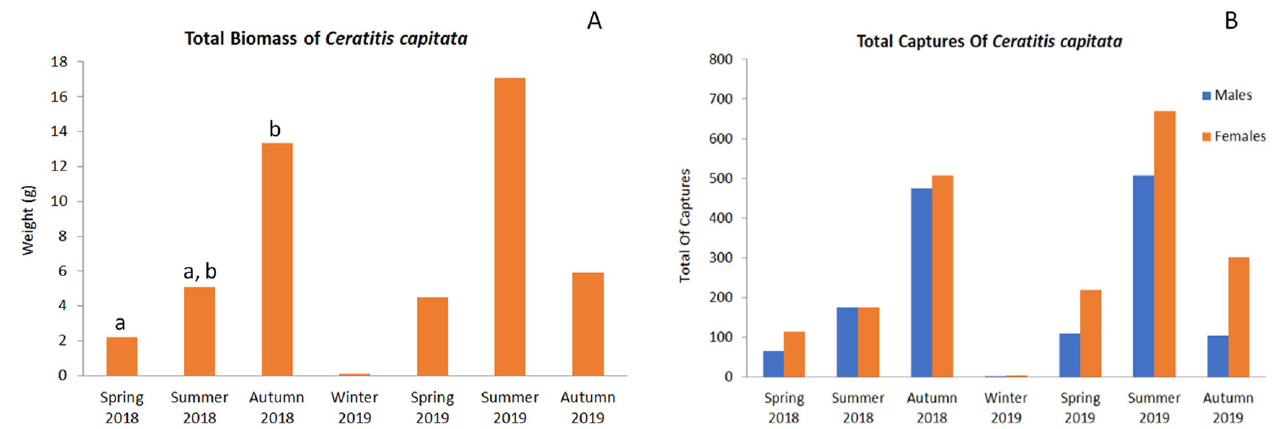
Figure 9. Total biomass ( A ) and the total number of males and females ( B ) of C. capitata captured in QV. Different letters indicate a significant difference among them ( p ≤ 0.05).